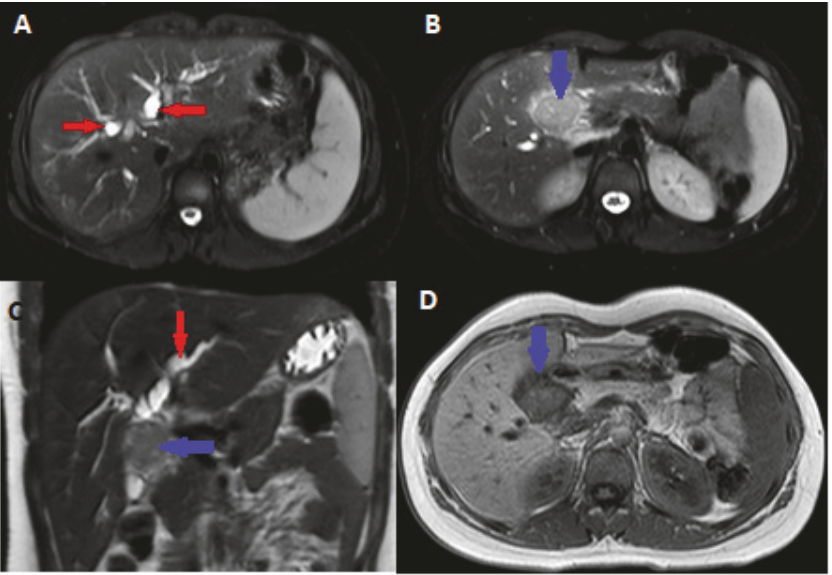
Figure 2: Axial (A, B) and coronal (C) T2-weighted images show a hyperintense mass in the region of the porta hepatis (blue arrow) with a dilated biliary ducts (red arrow). The mass (blue arrow) is hypointense in T1-weighted images (D).